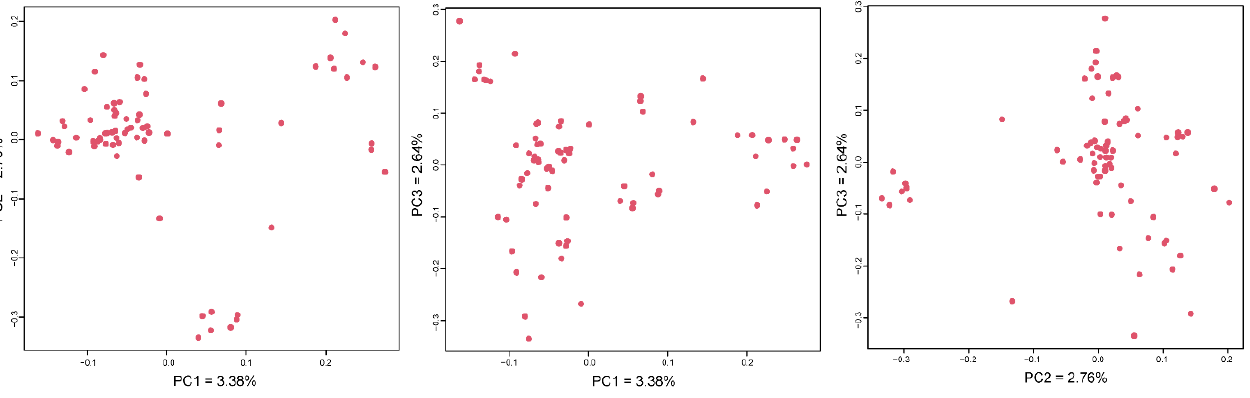
Figure 1. PCA analysis results.